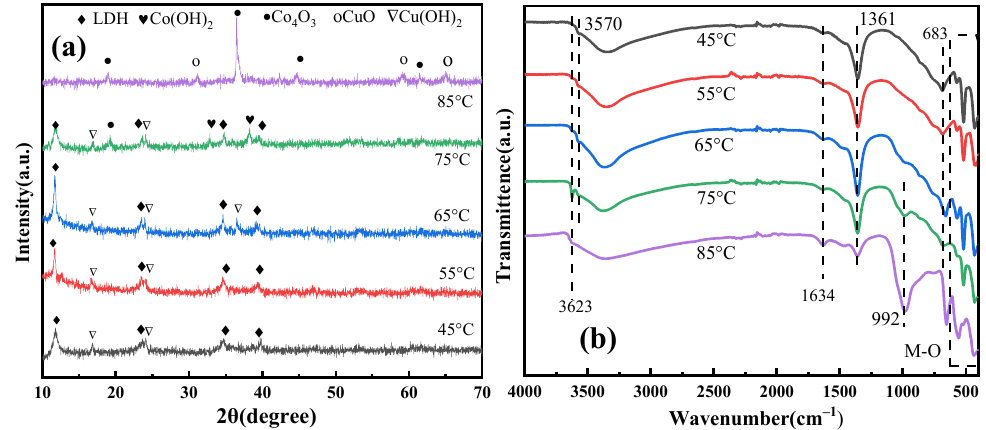
Figure 2. ( a ) XRD patterns of catalysts; ( b ) FT-IR spectra of catalysts.